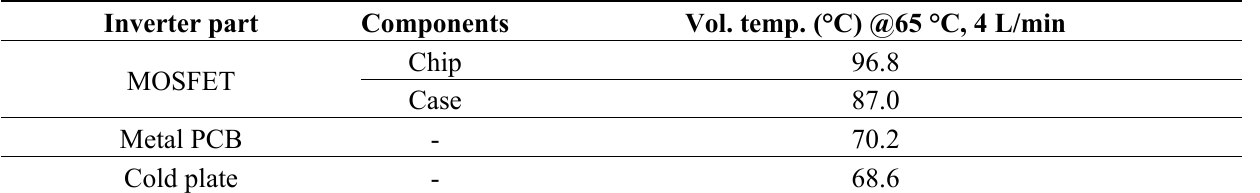
Table 6. Temperature values of each inverter